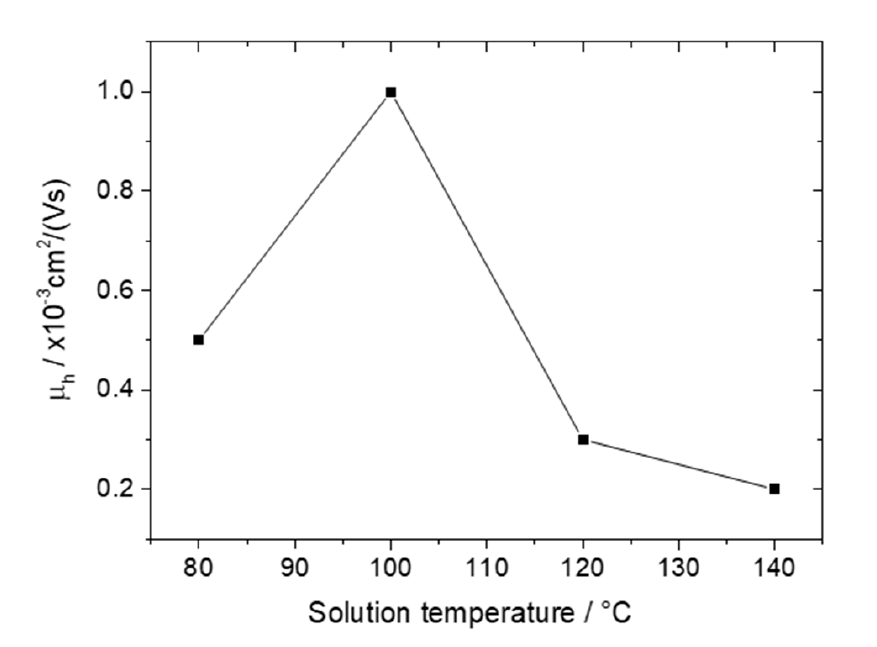
Figure 4. Field-effect mobility of holes as function of solution temperature for PBTTT-C 14 :PDI8-CN 2 BHJ films deposited at 4000 rpm and thermally annealed at 140 °C.